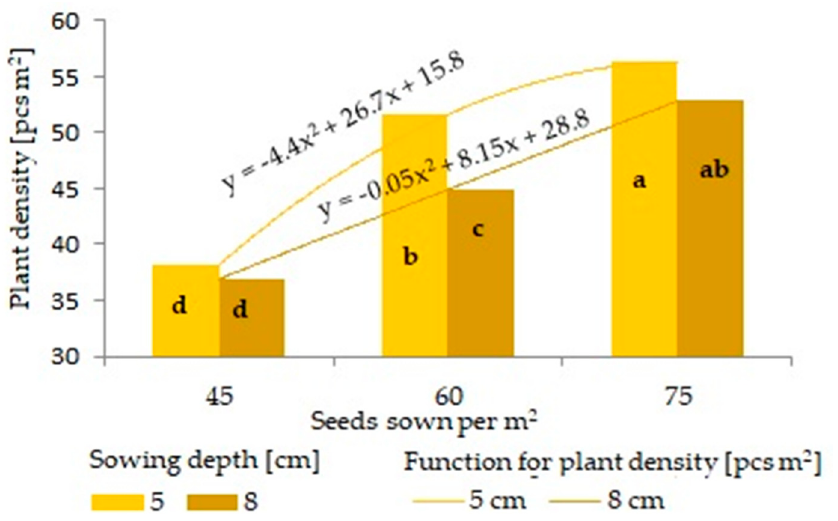
Figure 4. Plant density before harvest in 2011 (interaction SDH × SDY). Different letters indicate significant differences between factors (Tukey’s multiple range test).